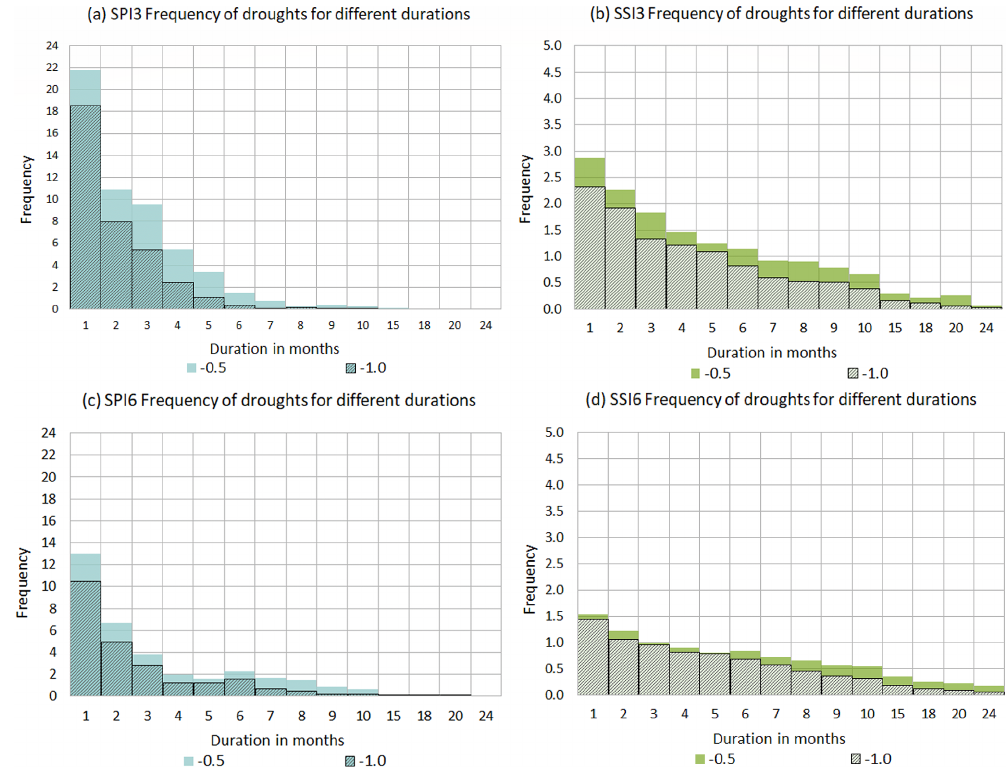
Figure 6. Histograms of droughts for different durations (in months) in the core crop region. (a) SPI3, (b) SSI3, (c) SPI6, and (d) SSI6. Color bars indicate mild to extreme droughts for which the values are less than X 1 = − 0 . 5. Hatched bars in all the panels indicate moderate to extreme droughts for which the values are less than X 2 = − 1. All computations were done from January 1979 to December